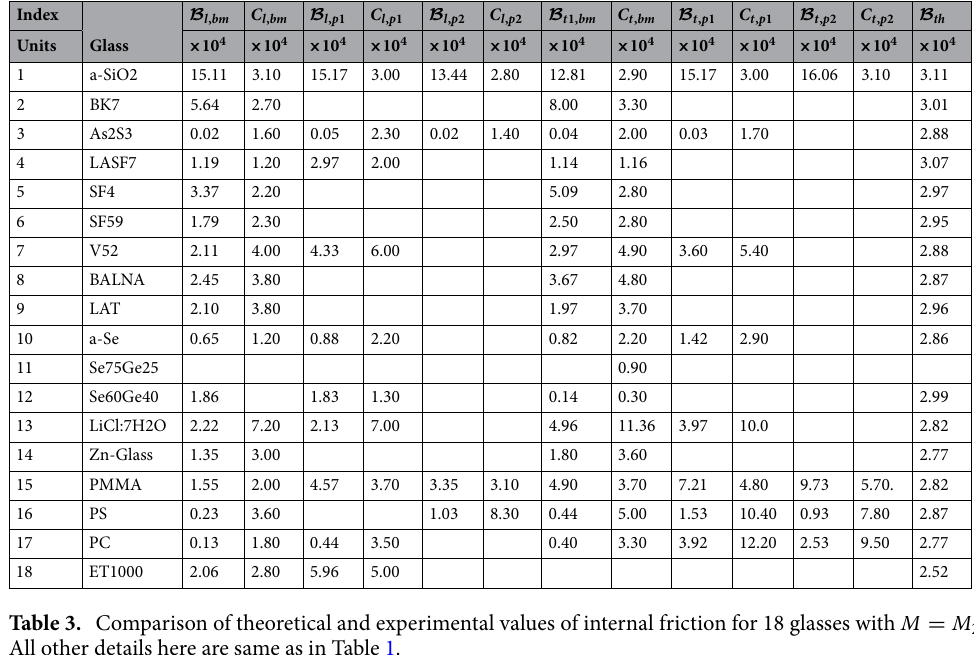
Table 3. Comparison of theoretical and experimental values of internal friction for 18 glasses with M All other details here are same as in Table 1.